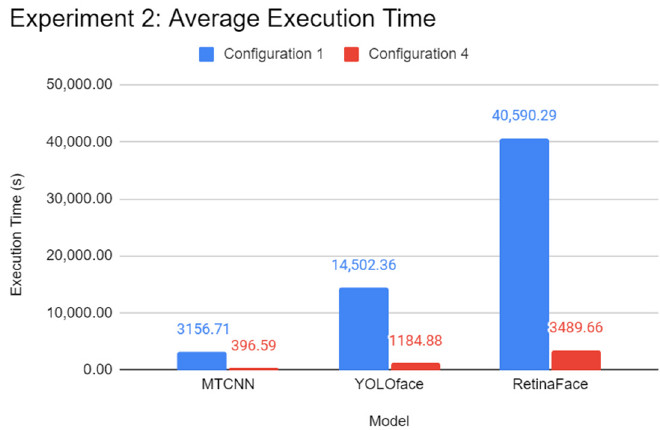
Figure 8. Average execution time results for Experiment 2.